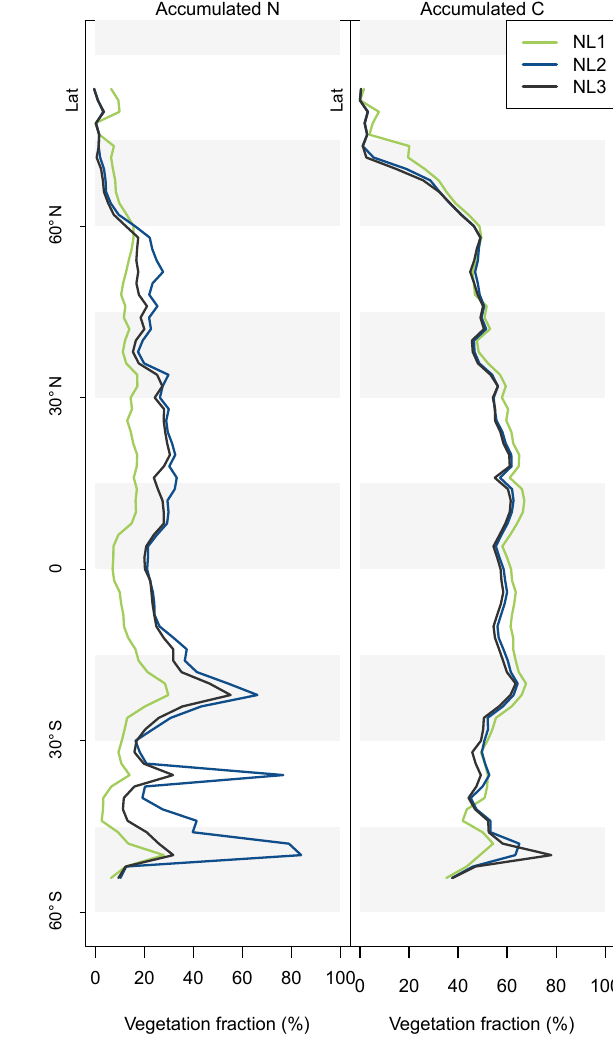
Figure A1. Latitudinal accumulation of nitrogen (N) in the veg- etation (left) or soil organic matter + litter (right) compartments during global simulations of elevated atmospheric CO 2 concentra- tions (eCO 2 ) using three different N loss algorithms between 1850 (285ppmCO 2 ) and 2100 (936ppmCO 2 ), depicted per 2 ◦ latitudi- nal band and as global totals (coloured numbers).